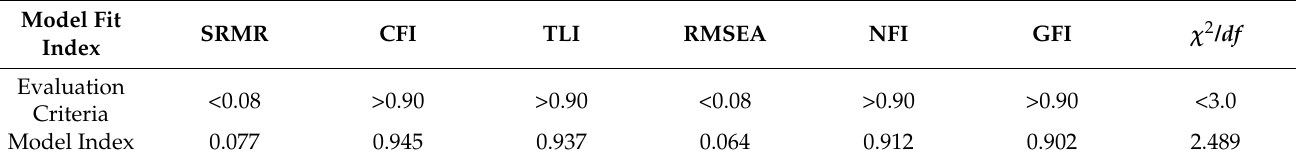
Table 6. Assessment of model suitability.